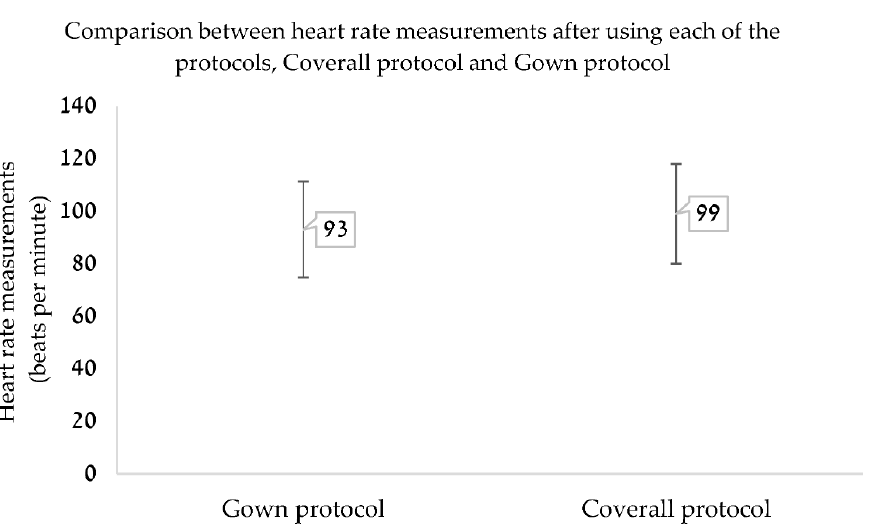
Figure 4. Comparison of heart rate measurements and dispersion indices (mean and standard deviation) after using each of the protocols.